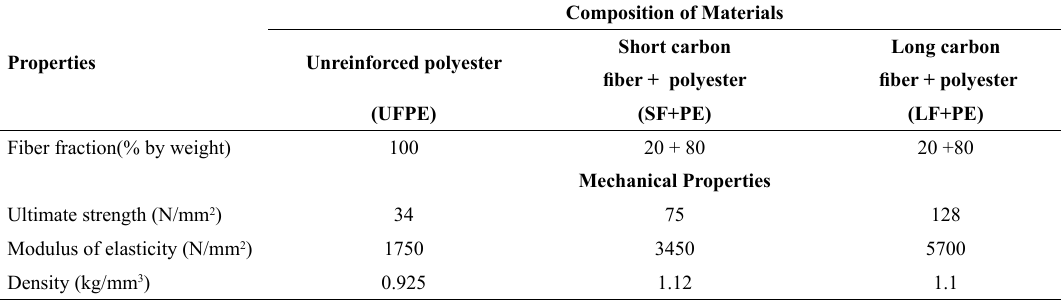
Table 1. Composition and mechanical Properties of unreinforced and reinforced polyester composites